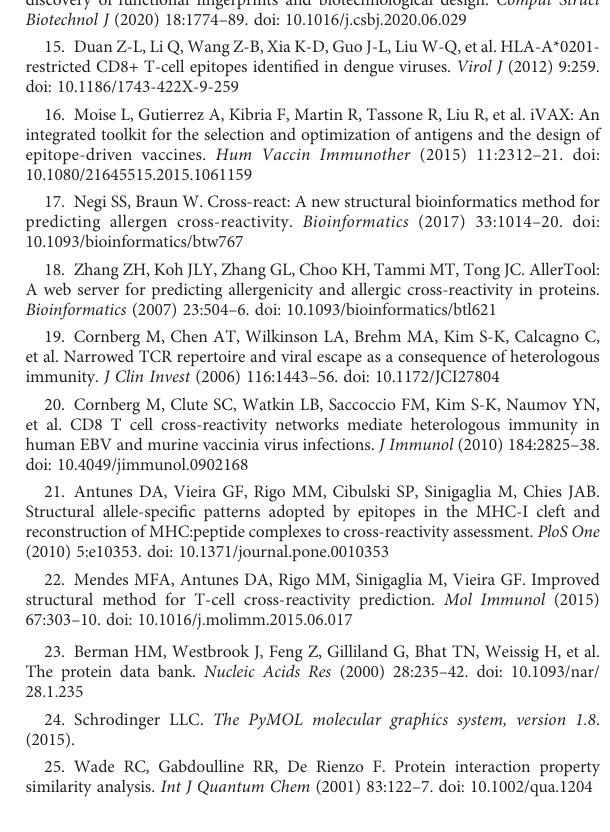
RMSD values (in Angström) of pMHCs used for MatchTope validation compared to the pdb model after fi tting. The low RMSD values shown here (below 0.1 Angström) demonstrate that all pMHCs are in the same position. The last row presents the overall mean for all